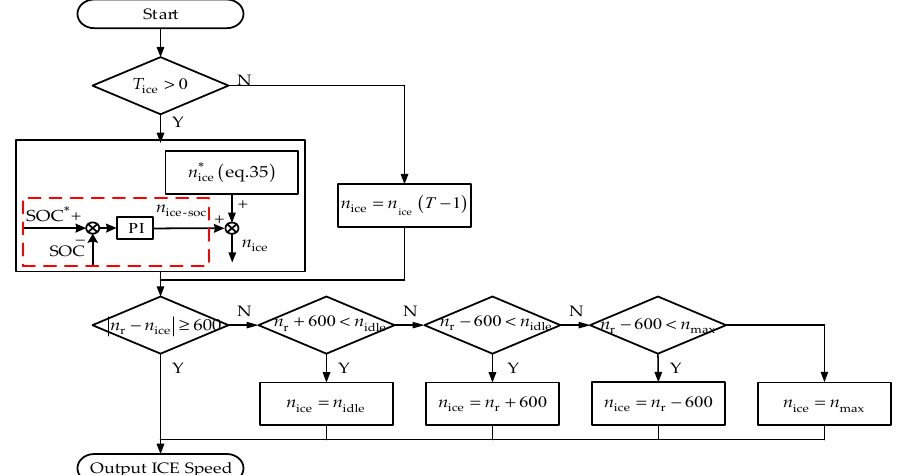
Figure 13. Flowchart of the ICE speed optimization strategy.